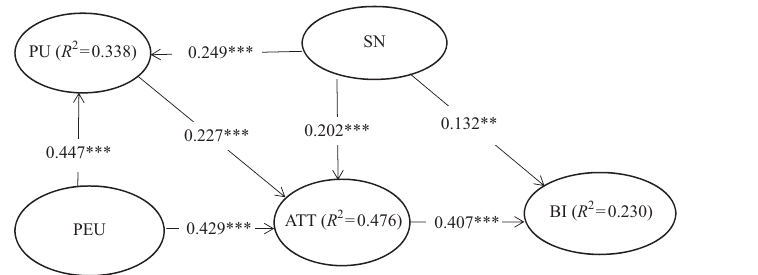
Figure 3. PLS results for structural